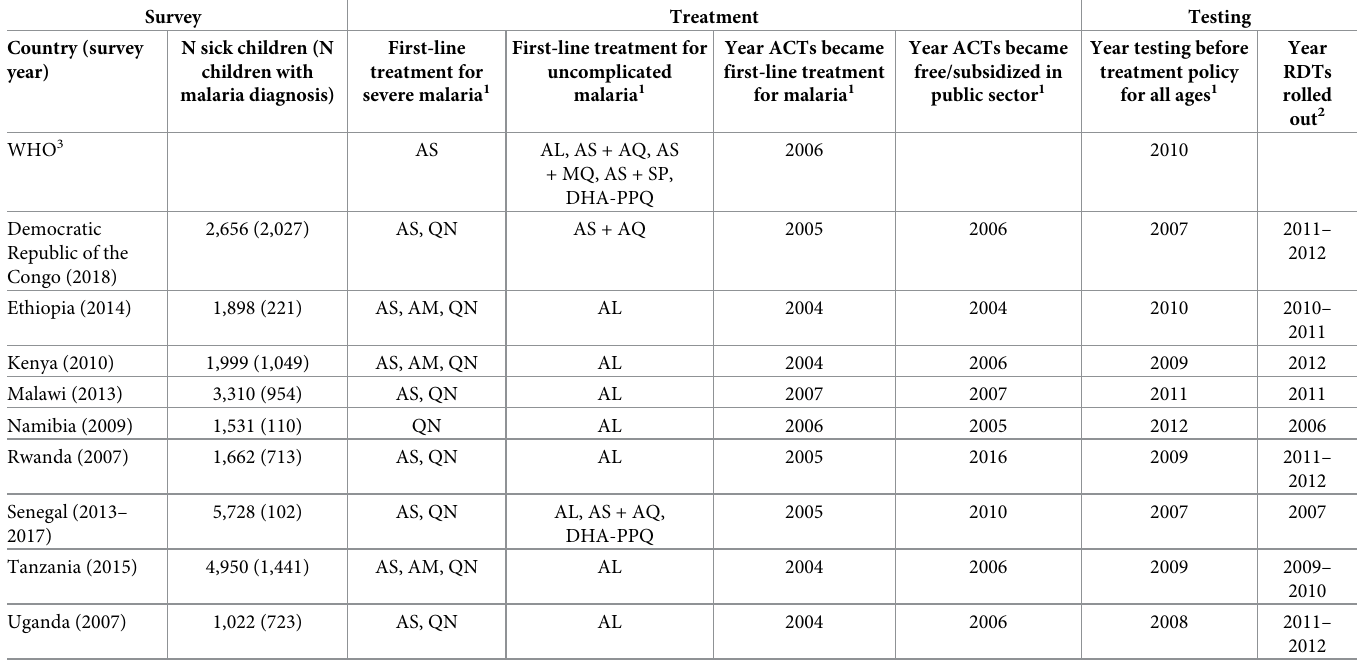
Table 1. Malaria policy changes and introduction of ACTs and RDTs by country.